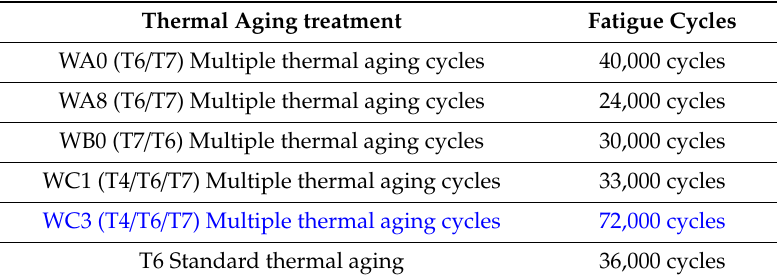
Table 1. Fatigue cycles of the A357 aluminum semi-solid applicable parts.